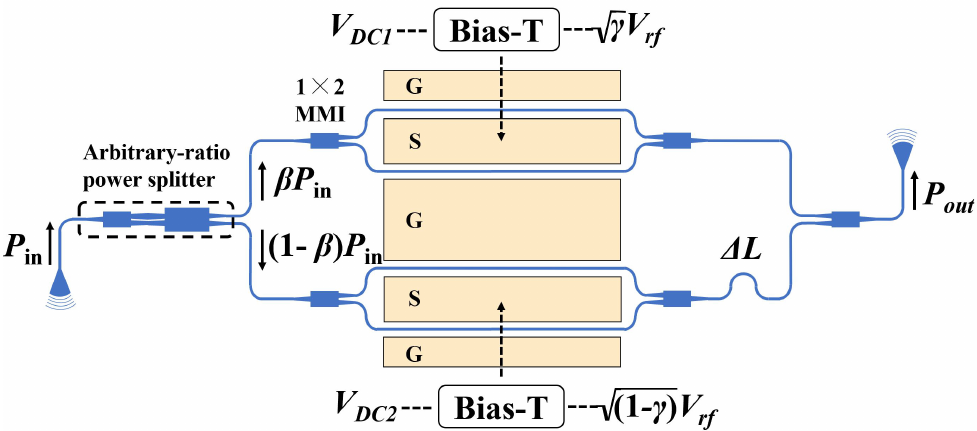
Figure 1. Schematic view of the proposed DP-MZM based on the TFLN platform. The sub-MZMs are biased at opposite quadrature transmission points ( ± π /2) with different DC bias voltages denoted as V DC 1 and V DC 2 , respectively. Under these specific bias conditions, the third-order intermodulation distortion components of the sub-MZMs are √ √ γ V rf and out of phase. Thus, with different RF levels of 1 − γ V rf , the IMD3 components could completely cancel out with each